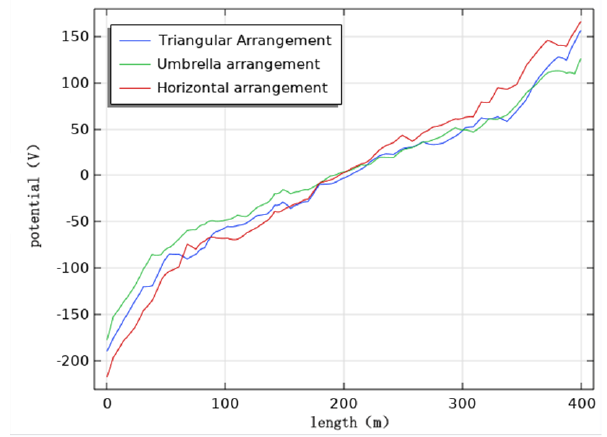
Figure 23. Distribution of cathodic protection potential during the umbrella arrangement of conductors.